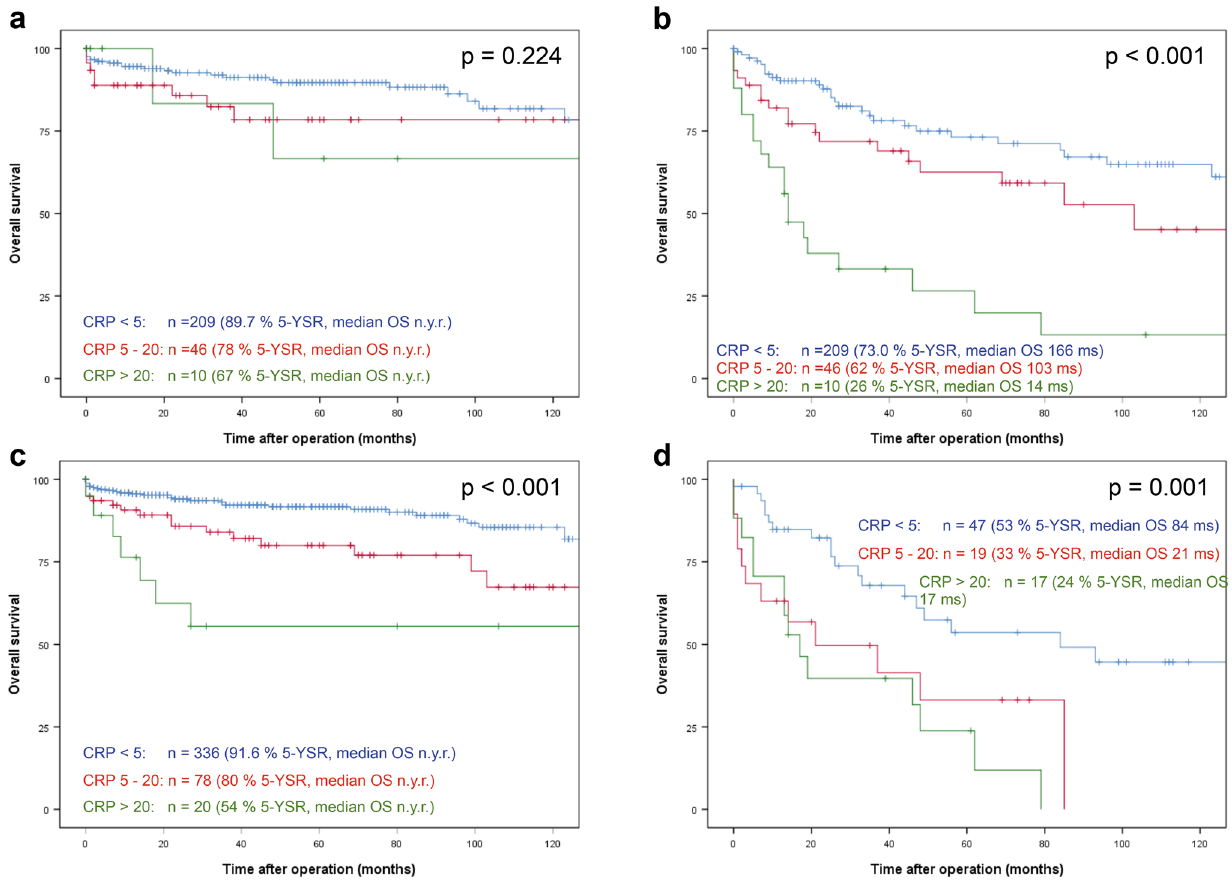
Figure 3. Association of lymph node and distant metastases with survival in serum CRP subgroups. Overall survival rate in resected pNEN patients in node negative (a) and node positive patients (b) and patients without (c) or with distant metastases (d) at primary presentation. Group 1: CRP < 5 mg/l; group 2: CRP 5–20 mg/l; group 3: CRP > 20 mg/l. Patients alive at last follow-up were censored. 5-YSR 5-year survival rate, OS overall survival, DFS disease-free survival, ms months, n.y.r. not yet reached.